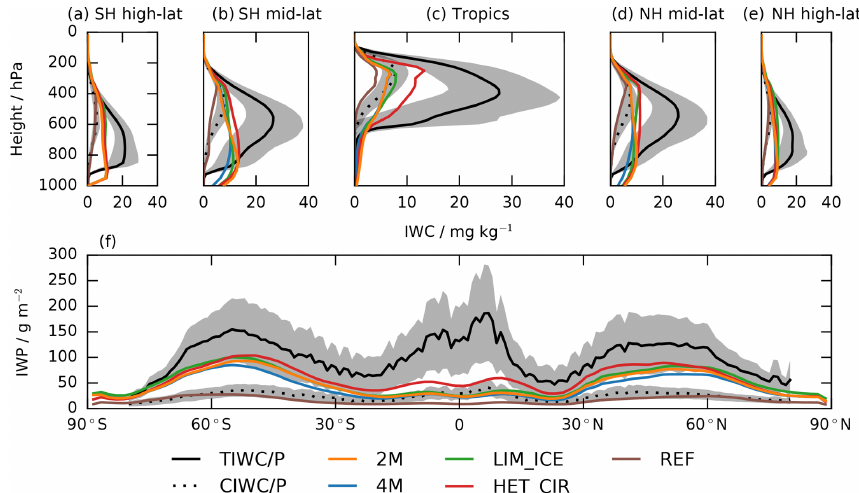
Figure 5. Ice water content and ice water path compiled from observations by Li et al. (2012) and different versions of ECHAM6-HAM2 (10-year zonal averages) with the new microphysics scheme and the reference model. Panels (a) – (e) show vertical profiles for ice water content, panel (f) shows ice water path. The observations in black include total ice water content/path (TIWC/P; solid lines) and cloud ice water content/path (CIWC/P; dotted lines). Colours show total (stratiform) ice water content from the new model and cloud ice water content from the reference model. The grey shaded areas represent the average standard deviation as reported by Li et al. (2012). The profiles are averaged over different latitude bands: SH high-lat (80 to 60 ◦ S), SH mid-lat (60 to 30 ◦ S), tropics (30 ◦ S to 30 ◦ N), NH mid-lat (30 to 60 ◦ N) and NH high-lat (60 to 80 ◦